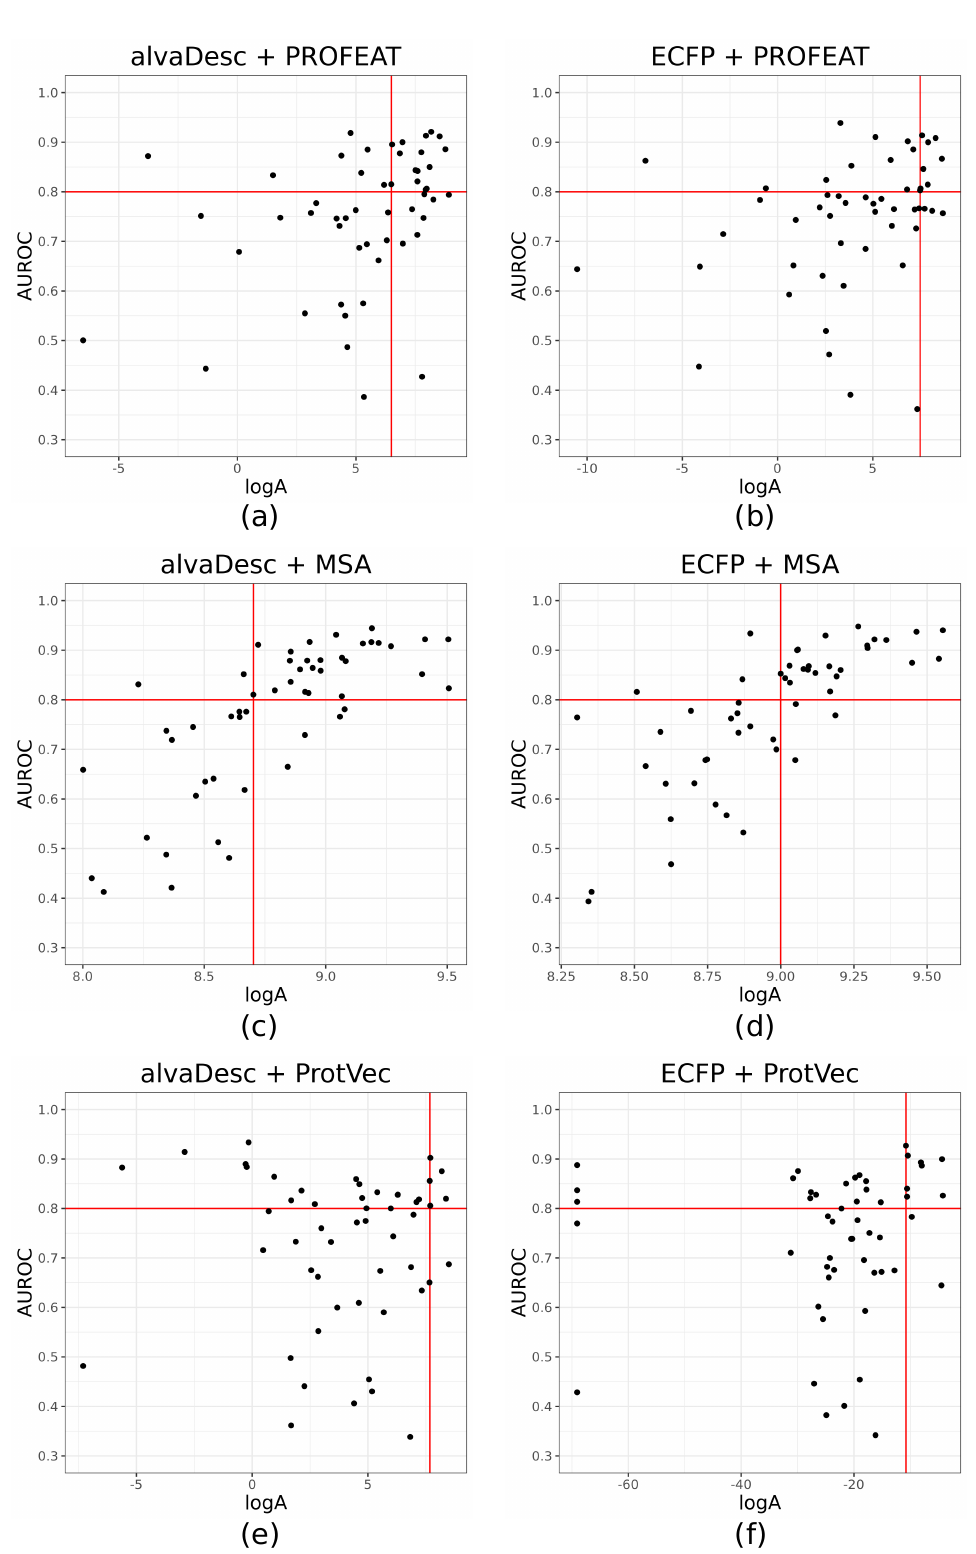
Figure 6. Relationship between applicability index and AUROC for six combinations of compound and protein descriptors. A horizontal red line indicates the AUROC value at 0.8. A vertical red line indicates the threshold value for the applicability index. ( a , b ) PROFEAT; ( c , d ) MSA; ( e , f )